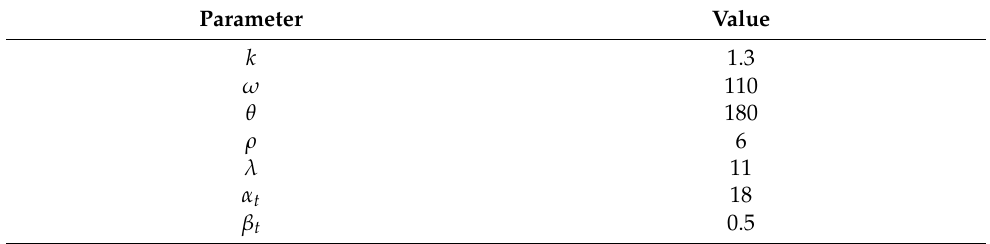
Table 2. Control system parameters. Parameter